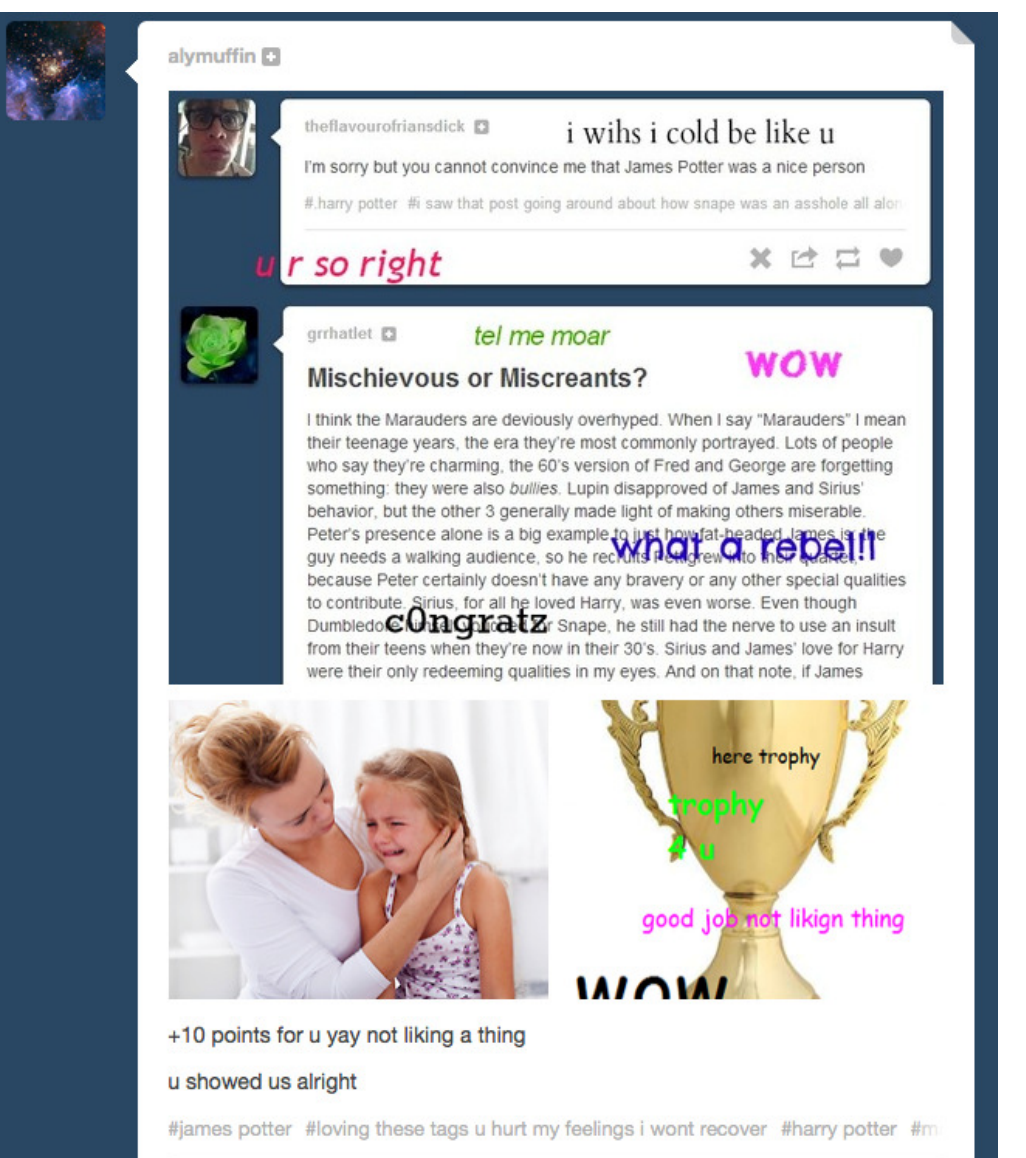
Figure 3. Screenshot of a screenshot of a Tumblr dashboard showing mockery of hyper-critical